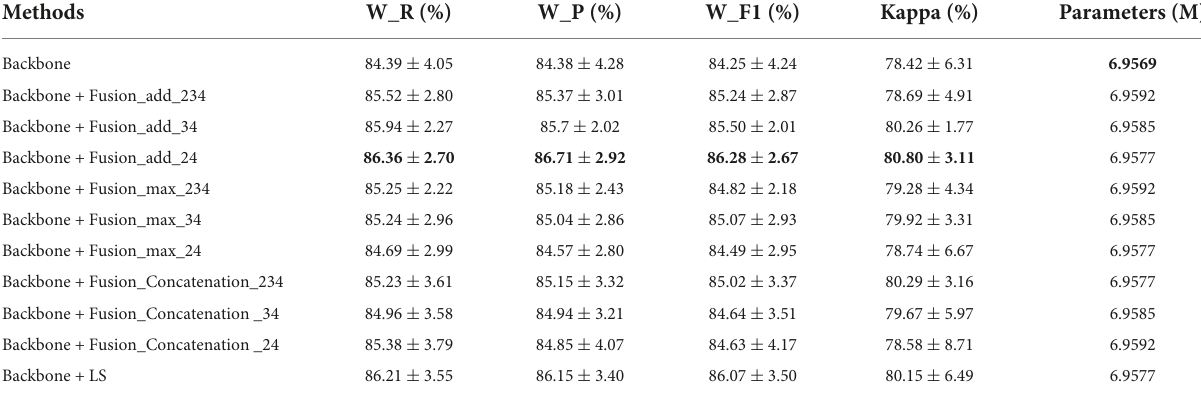
TABLE 4 The results of ablation experiments on general classification of corneal